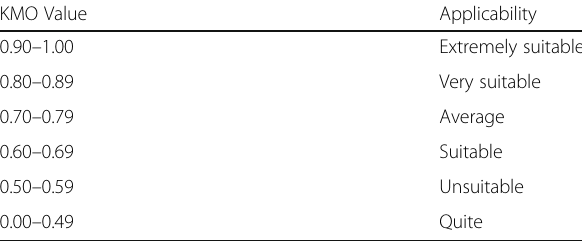
Table 1 Measurement standards of the KMO value KMO Value